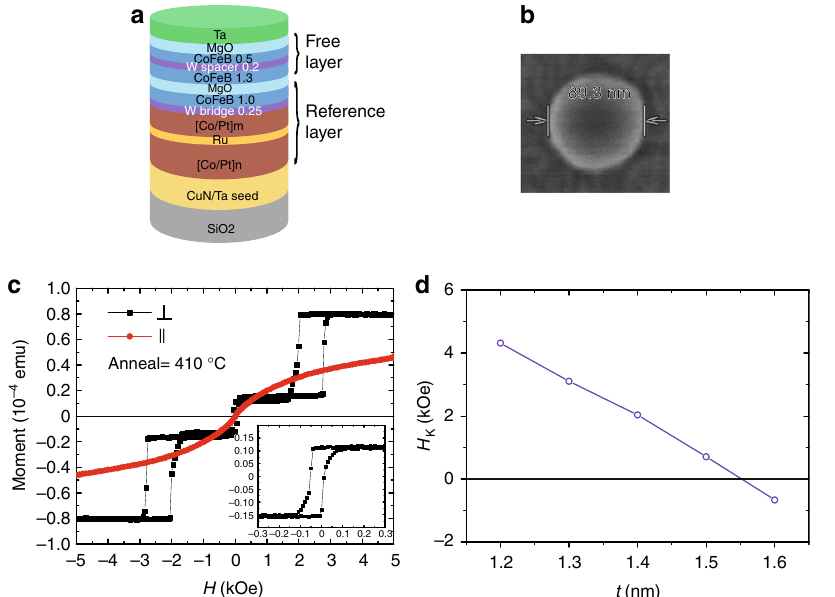
Fig. 1 Film con fi guration and magnetic properties. a Structure of the p-MTJ stack with MgO/CoFeB/W/CoFeB/MgO free layer and W bridging layer; Co/Pt multilayers are synthetic antiferromagnetic (SAF) layers for bottom pinning. b Top view of the p-MTJ pattern ( r = 45 nm) taken by scanning electron microscope. c Out-of-plane ( ⊥ ) and in-plane ( ∥ ) magnetic fi elds induced hysteresis loops of the p-MTJ fi lm annealed at 410 °C measured by PPMS-VSM; inset is the minor loop. d Dependence of H K on